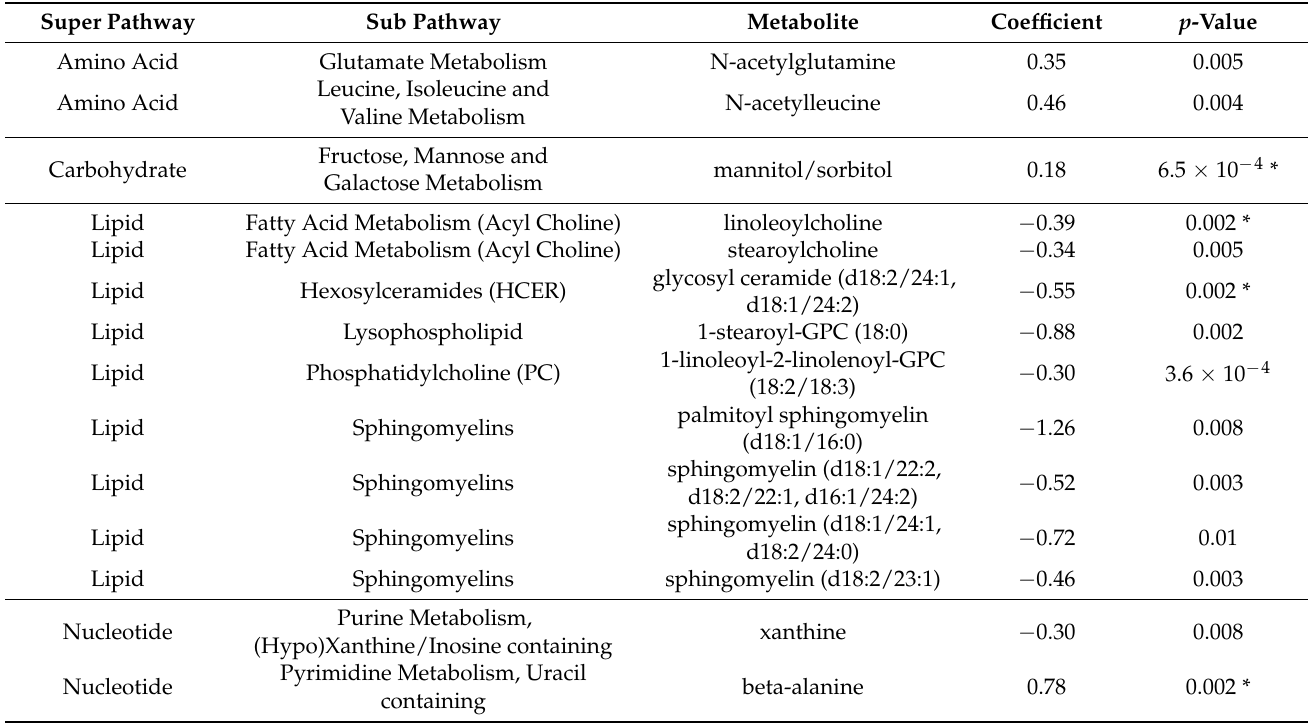
Table 3. Metabolites associated with AUDAC ( p -value < 0.01).